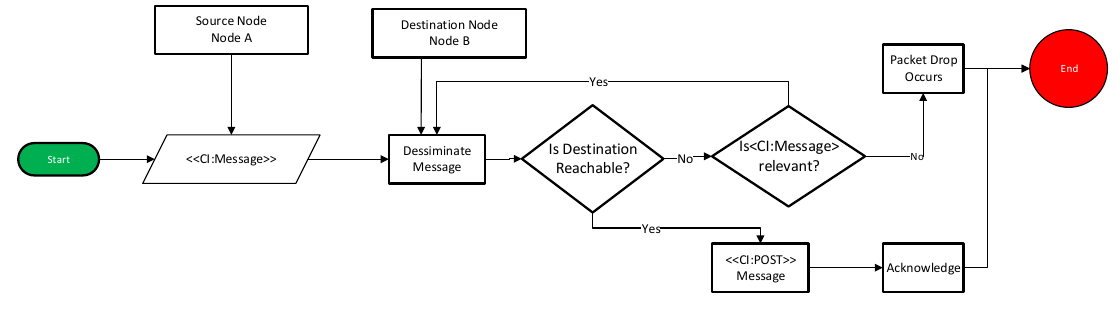
Figure 4. Proposed Protocol Flowchart.